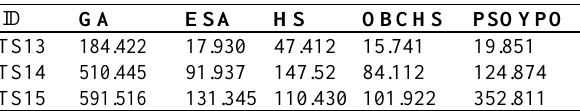
Table 8. Comparison of computational performance for LS problems